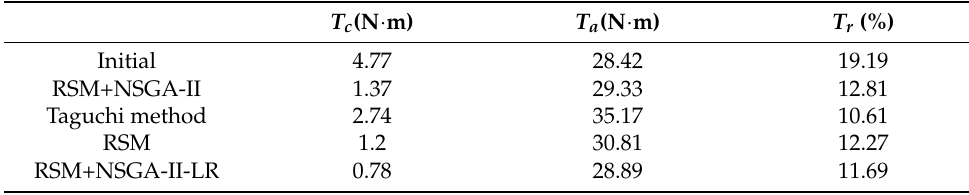
Table 5. Torque performance of the motor before and after optimization.